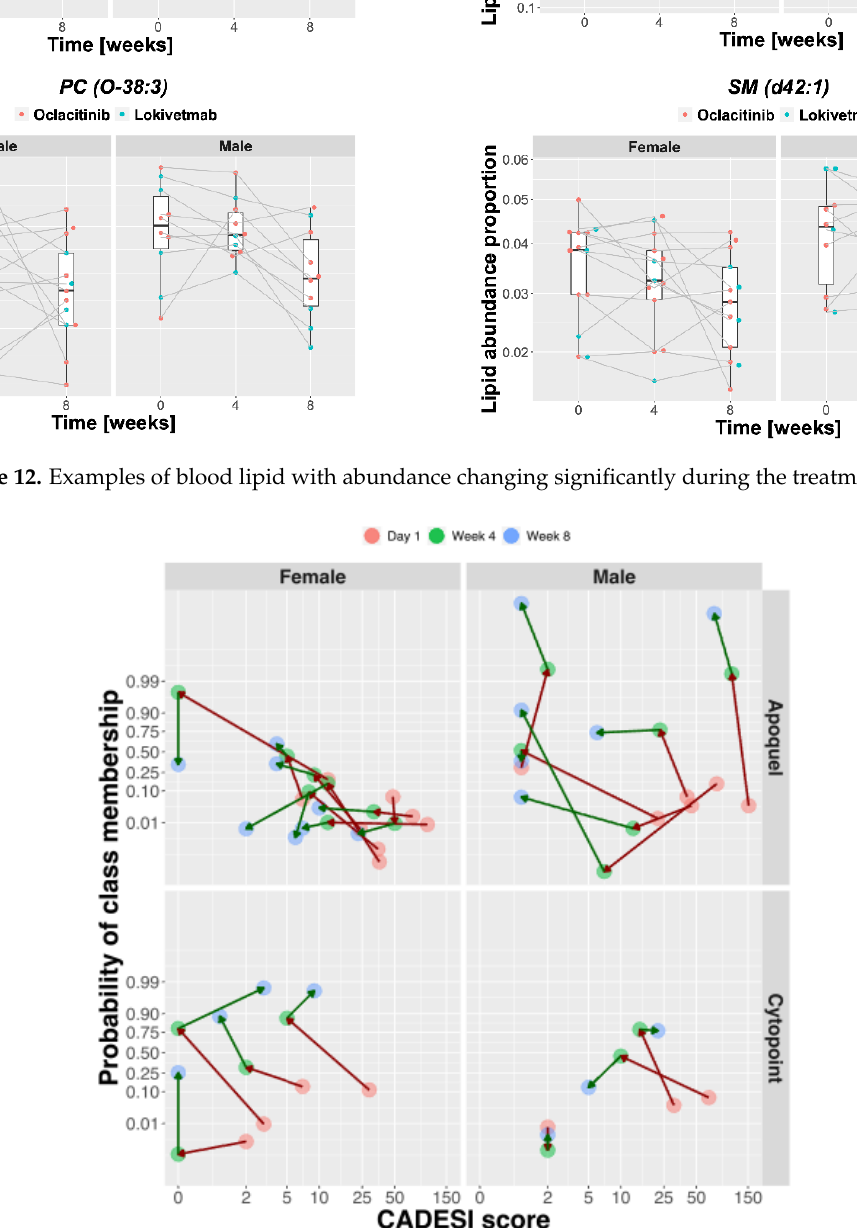
Figure 13. Changes in probability of classifying a fingerprint as healthy vs. the CADESI score. The arrows represent treatment trajectories of individual dogs.